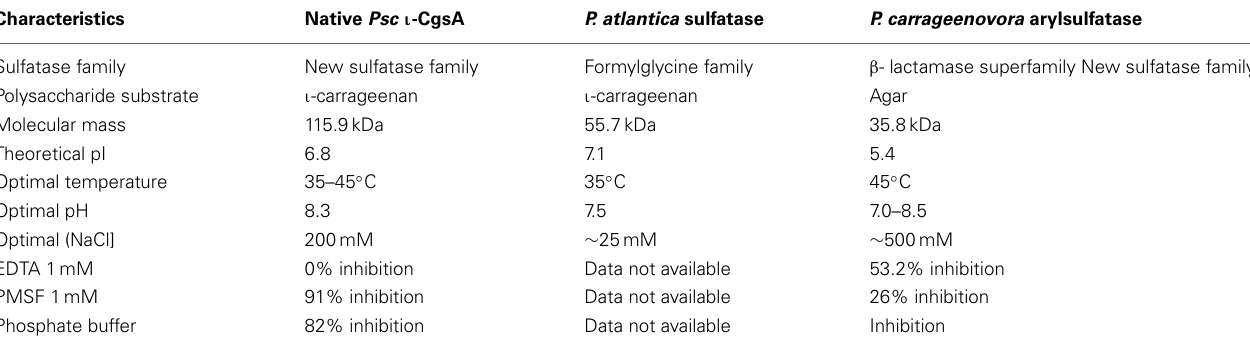
Table 2 | Biochemical characterization of the native Psc ι -CgsA compared to two other polysaccharide sulfatases described in the literature.